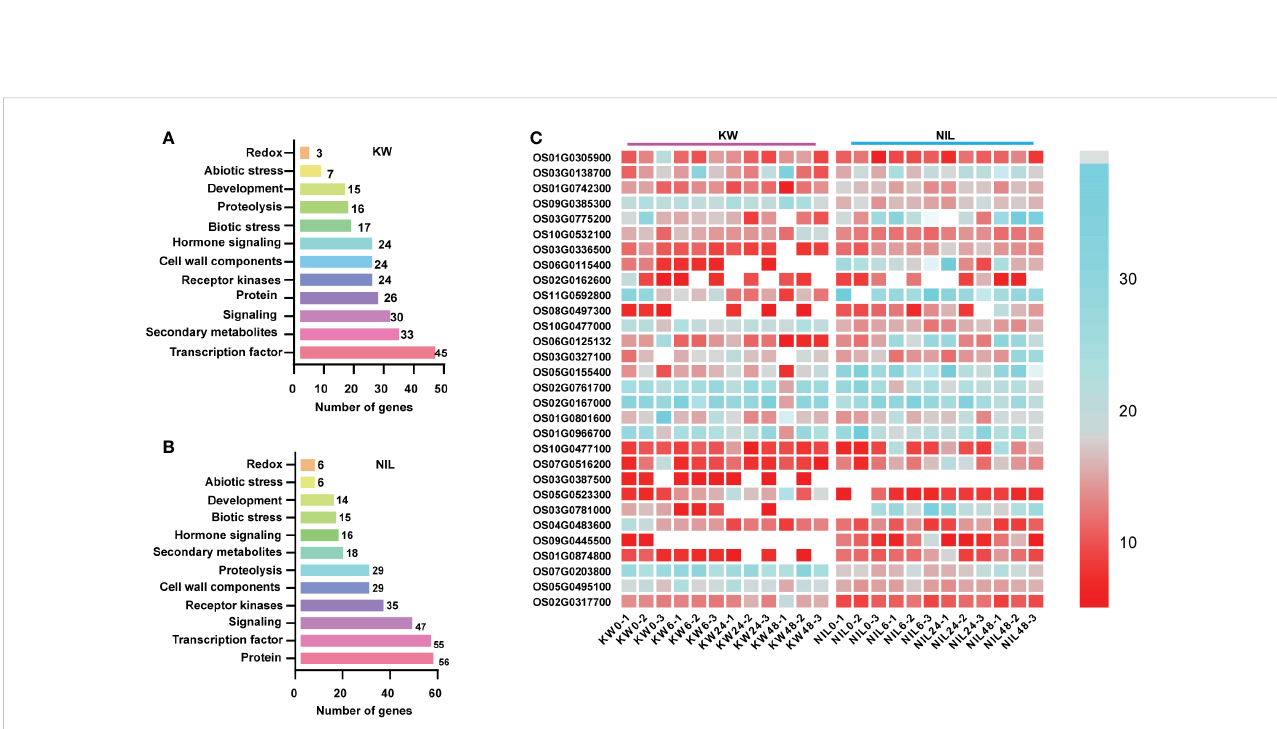
FIGURE 3 Distribution of DEGs into different pathways using MapMan. (A, B) Analysis of DEGs identi fi ed in different treatments of KW and NIL. The y-axis shows the distribution of genes into different pathways, while the x-axis represents the number of genes assumed for each category. (C) The heat map represents the expression level of DEGs identi fi ed in the study. The color scale indicates FPKM change (blue, low expression level, and red, high expression